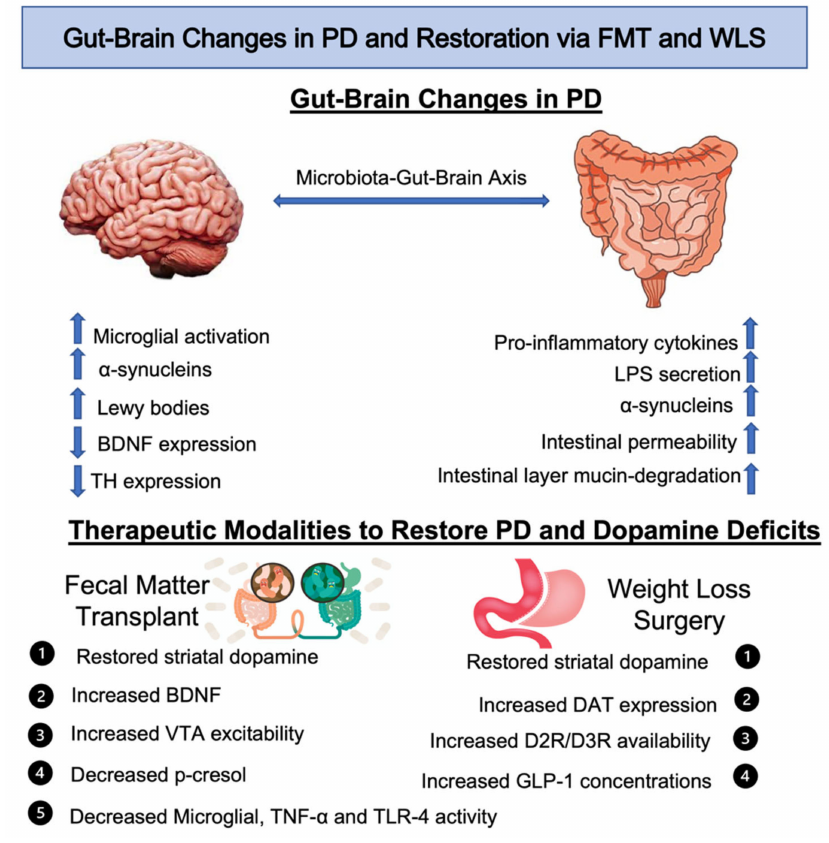
Figure 4. Gut-brain changes in Parkinson’s Disease and restoration of dopaminergic and Parkinson’s disease deficits via fecal microbiota transplant and weight loss surgery. Changes in the brain include decreased BDNF levels, reduced tyrosine hydroxylase expression, increased α -synuclein and mi- croglial activity. Changes in the gut include increased intestinal permeability, mucin-degradation and α -synucleins, LPS secretion and pro-inflammatory cytokines. Fecal microbiota transplant in- creases striatal dopamine concentrations, VTA dopamine excitability and BDNF, while decreasing p-cresol levels and microglial activity. Weight loss surgery increases DAT expression, D2R/D3R expression, GLP-1 levels, and striatal dopamine concentrations. Abbreviations: BDNF, brain derived neurotrophic factor; TH, tyrosine hydroxylase; LPS, lipopolysaccharide; TNF- α , tumor necrosis factor α ; TLR-4, toll-like receptor 4; VTA, ventral tegmental area; DAT, dopamine transporter; D2R, dopamine 2 receptor; D3R, dopamine 3 receptor; DAT, dopamine transporter; GLP-1, glucagon-like peptide 1; FMT, fecal microbiota transplant; WLS, weight loss